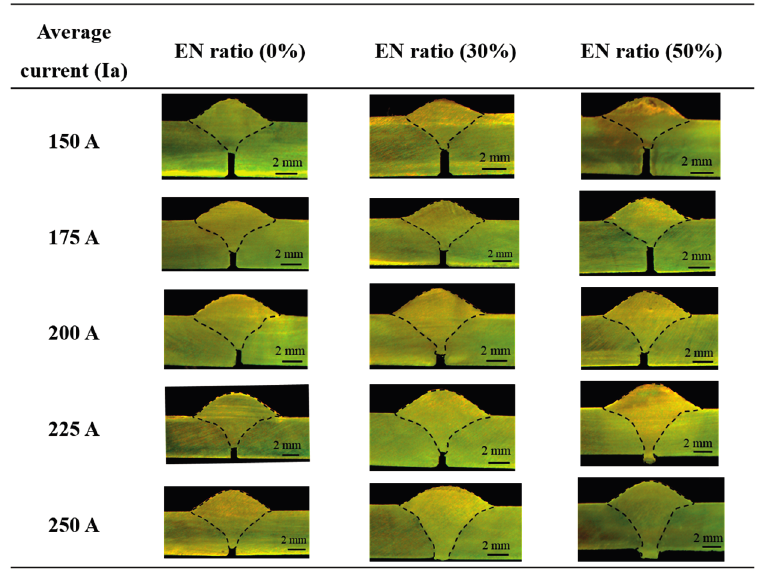
Figure 6. Macro-sections of welded joints at different Ia and EN